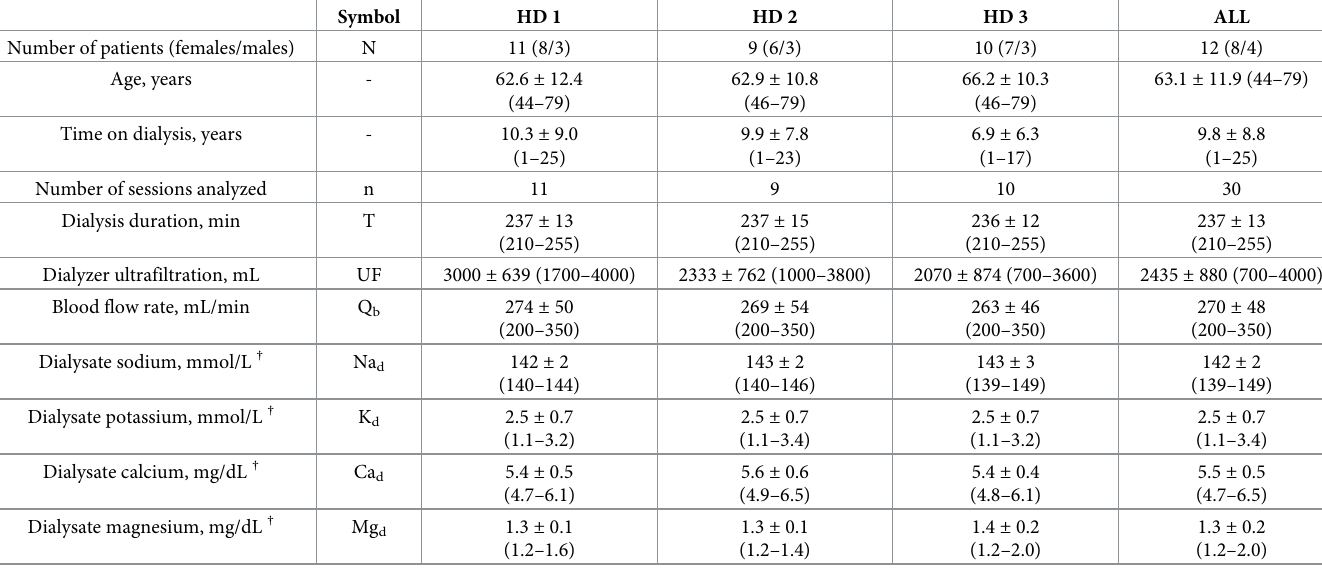
Table 2. Patient characteristics and dialysis settings for the first (HD 1), second (HD 2), third (HD 3) and all HD sessions. All data presented as mean ± SD